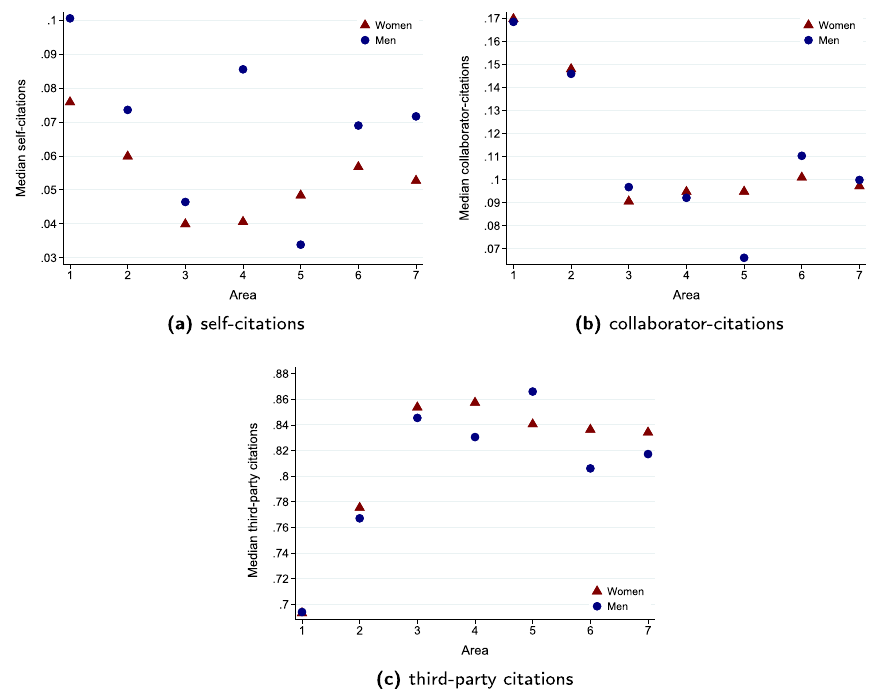
Fig. 5 Type of citations according to area and gender: